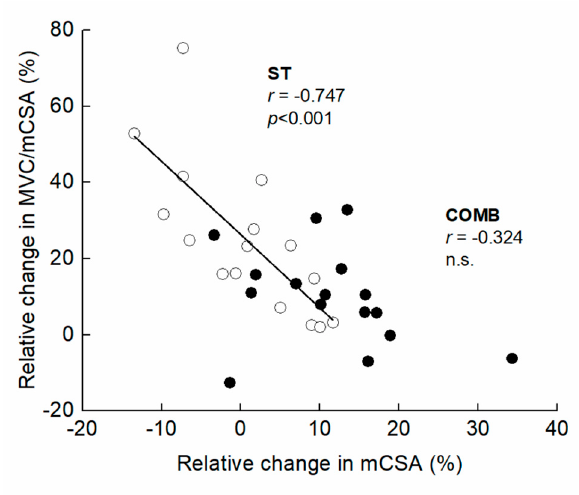
Figure 4. Association of relative change in maximal voluntary isometric contraction per muscle cross-sectional area (MVC/mCSA) with relative change in mCSA from Mid to Post for the elbow flexors. The filled and open circles denote COMB and ST, respectively.